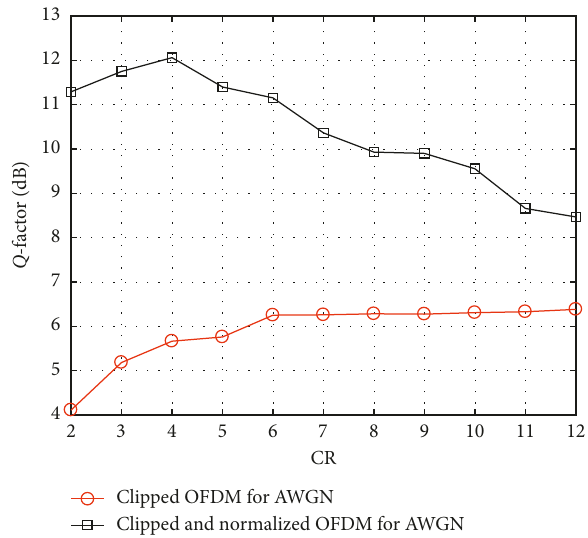
Figure 2: Q factor values as a function of the clipping ratio in clipped QPSK OFDM with and without normalization over the AWGN